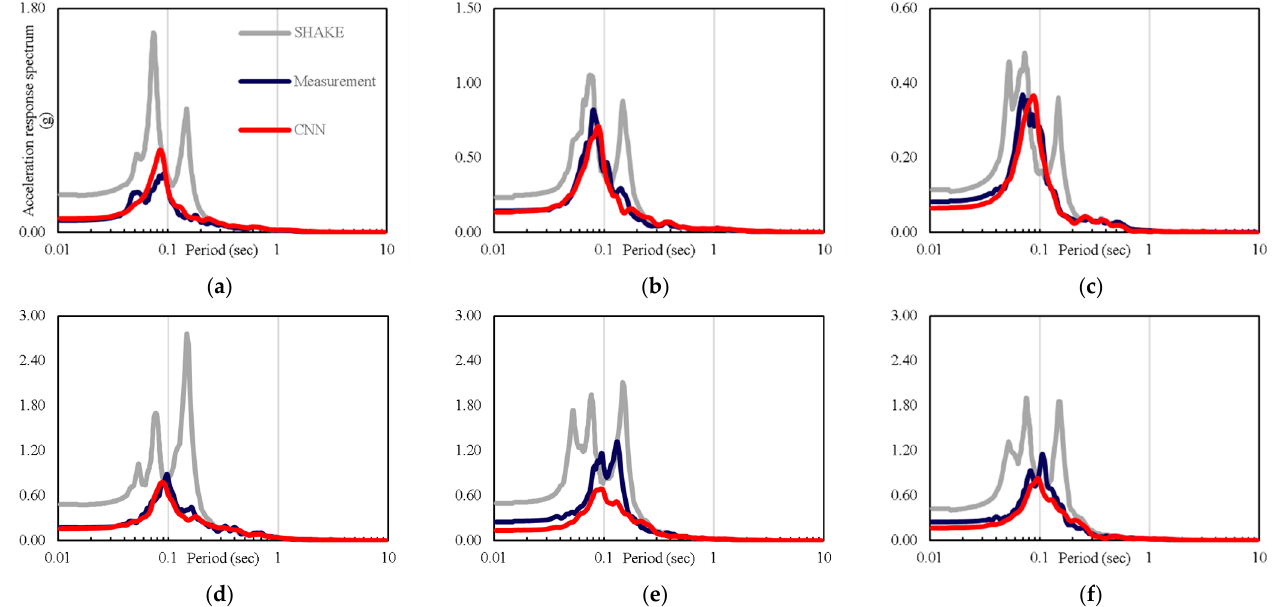
Figure 21. The six samples of acceleration response spectra measurements and predictions at site MYGH04. ( a )